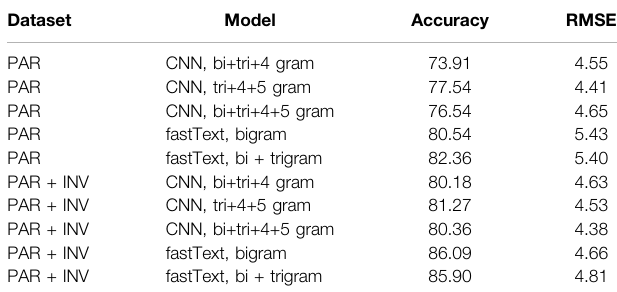
TABLE 2 | Average 5-fold cross-validation results for AD classi fi cation and RMSE values.